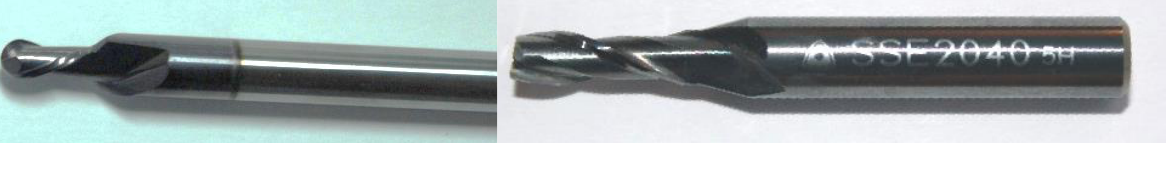
Table 1. Technical characteristics of the cutting milling tools used in the machining process. Parameter